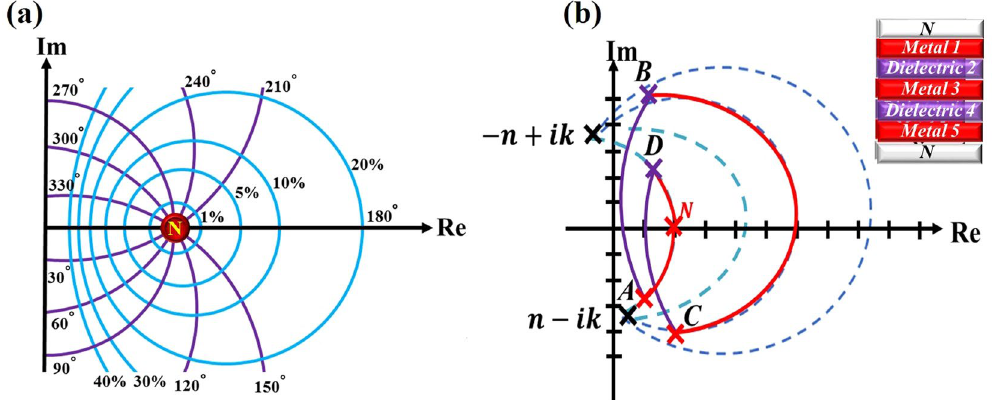
Figure 1. ( a ) Constant reflectance loci (blue lines) and constant phase loci (purple lines), ( b ) loci of an admittance-matching five-layered symmetrical film stack in